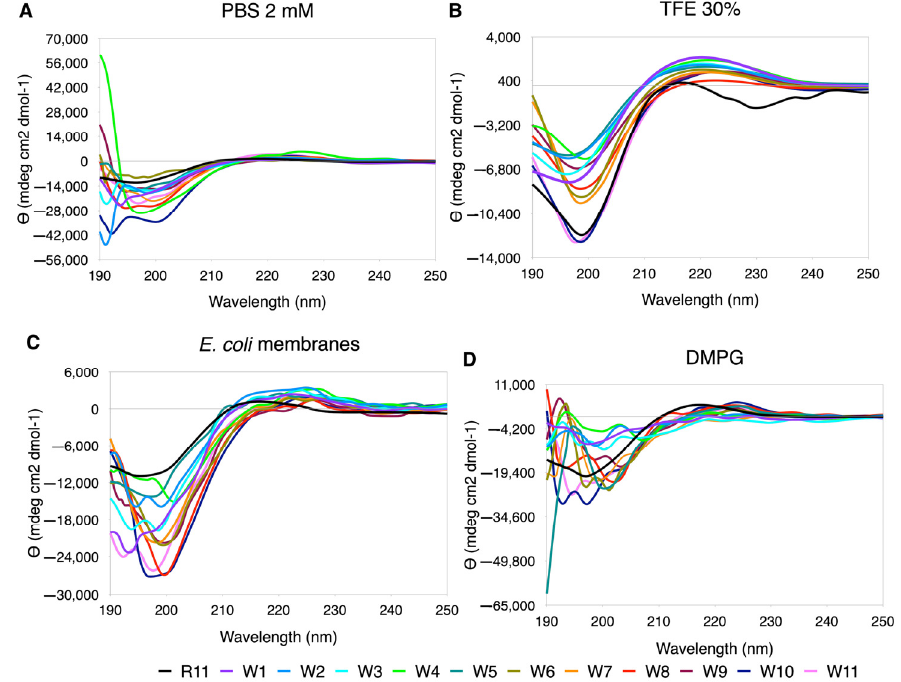
Figure 6. CD spectra for Trp scanning of R11 in the four media used. ( A ) TFE 30%. ( B ) PBS 2 mM. ( C ) DMPG. ( D ) E. coli membranes extract. ( C ) DMPG. ( D ) E. coli membranes